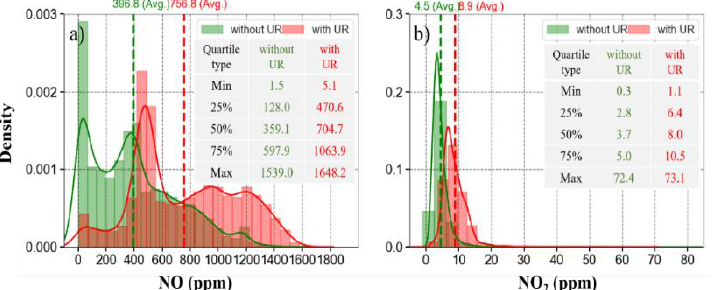
Figure 1. Comparison of the density distributions for NO ( a ) and NO 2 ( b ) volumetric concentrations with and without the illegal application of urea